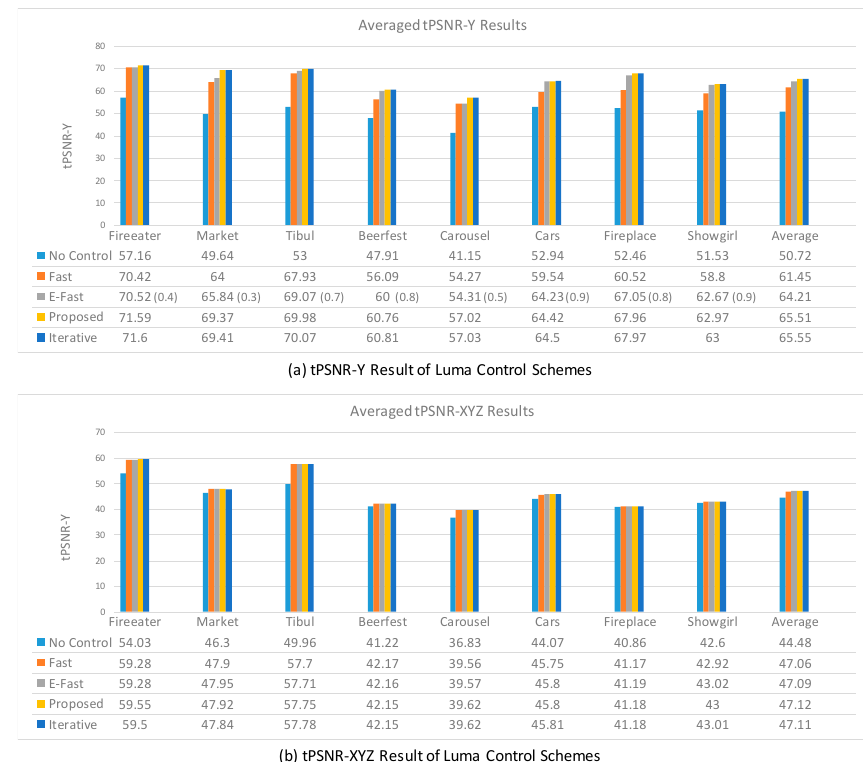
Figure 4. The enhancement results of different luma control algorithms in terms of tPSNR-Y in ( a ) and tPSNR-XYZ in ( b ). The number inside the brackets in the “E-Fast” row of ( a ) denotes the reduction factor, r , in (12), which was employed for the best result for each test sequence.